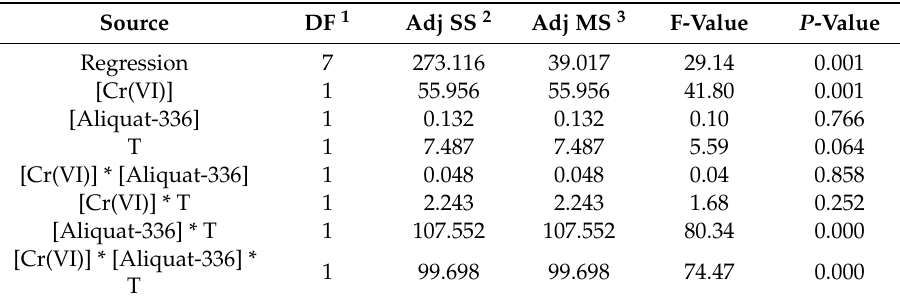
Table 7. Analysis of variance.